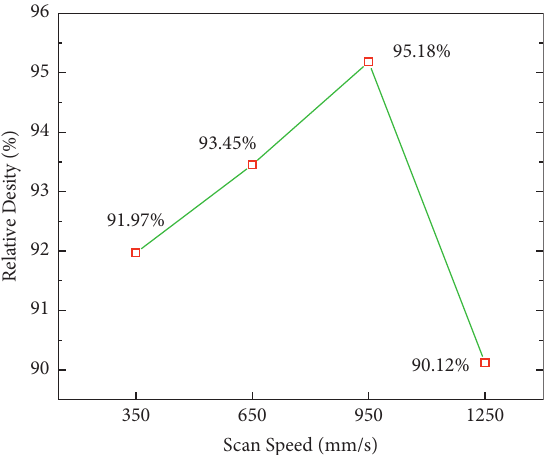
Figure 9: The density of specimens with different